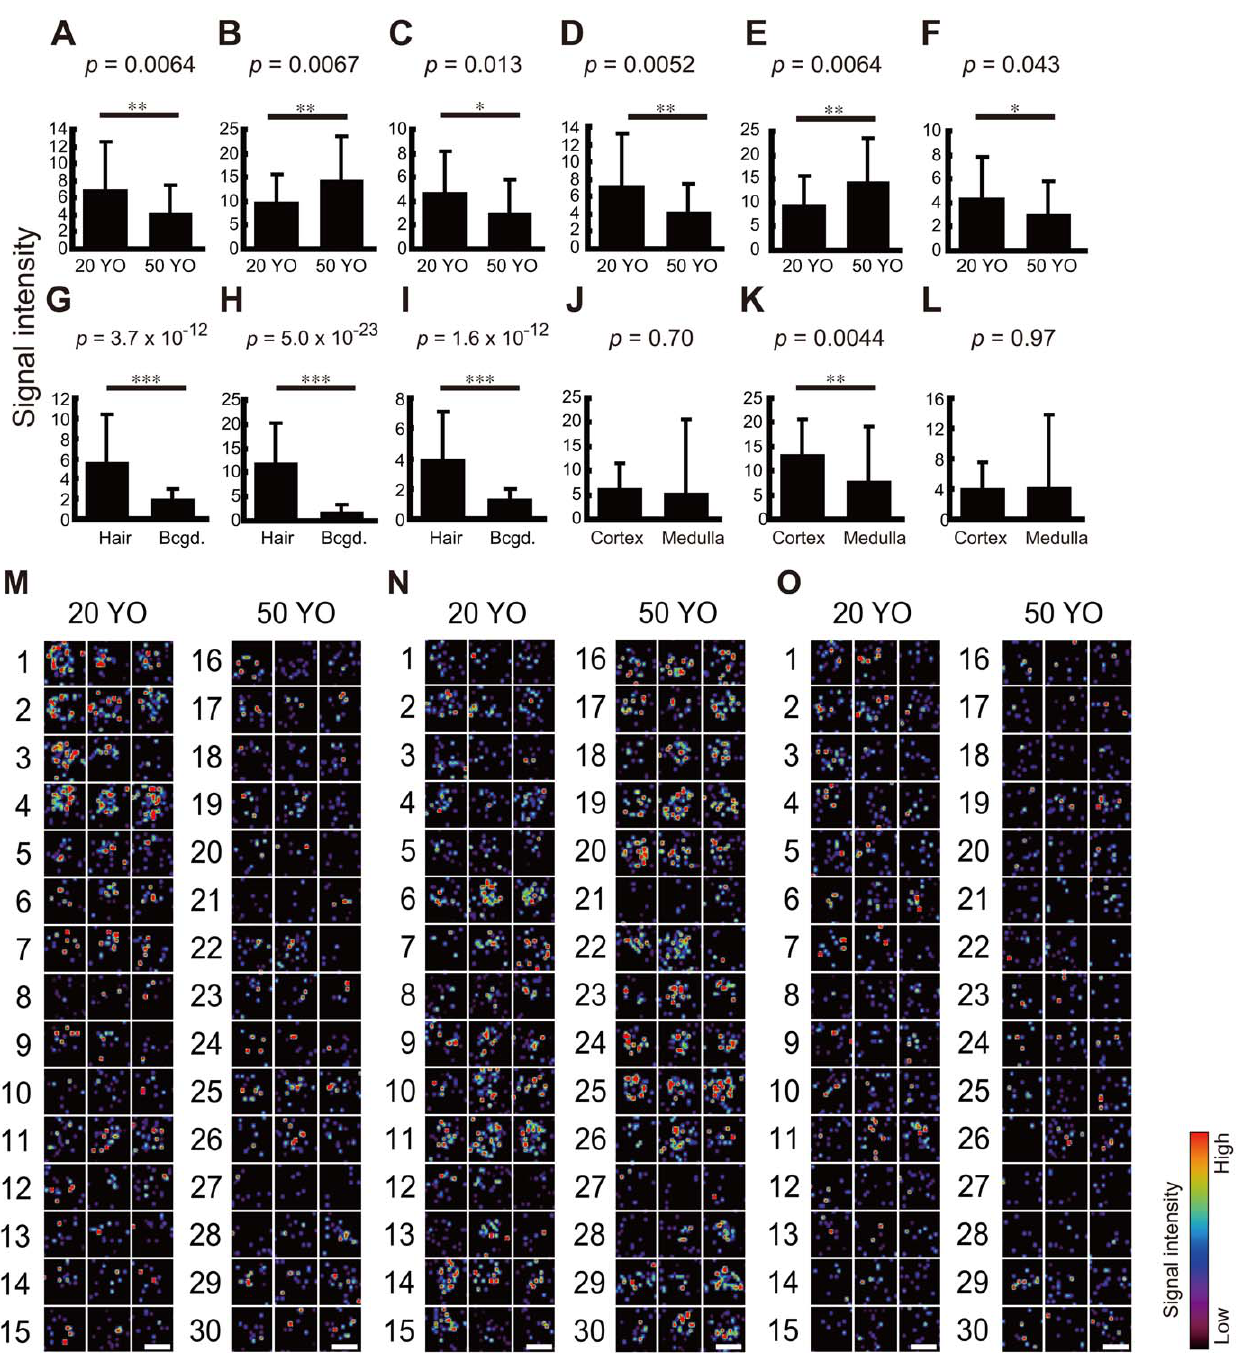
and background area is displayed. (J–L) Mean signal intensity in the cortex and medulla is displayed. (M–O) Each panel shows ion distribution in cross- sectioned hair. The number indicates the subject No. Each of the 3 pictures was obtained from an independent scalp hair of a single subject.